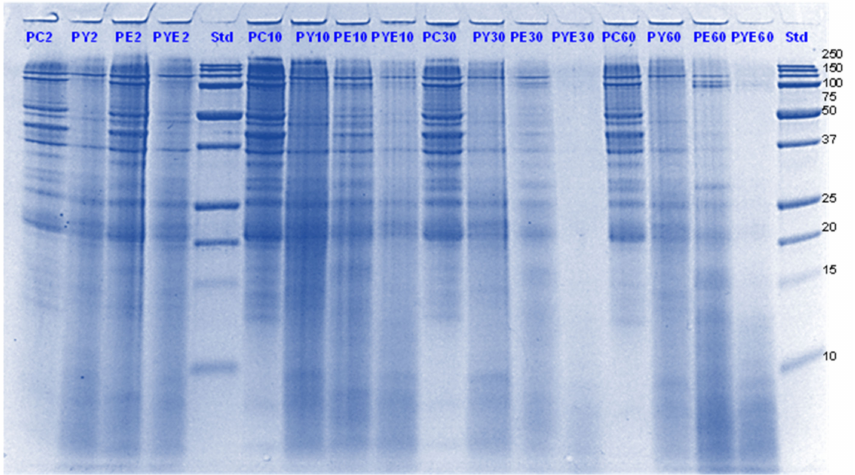
Figure 2. Tricine SDS-PAGE electrophoretogram of pea protein isolate after 2, 10, 30 and 60 min of simulated oral-gastric digestion in the presence or absence of SunGold (Y) kiwifruit extract. PC,